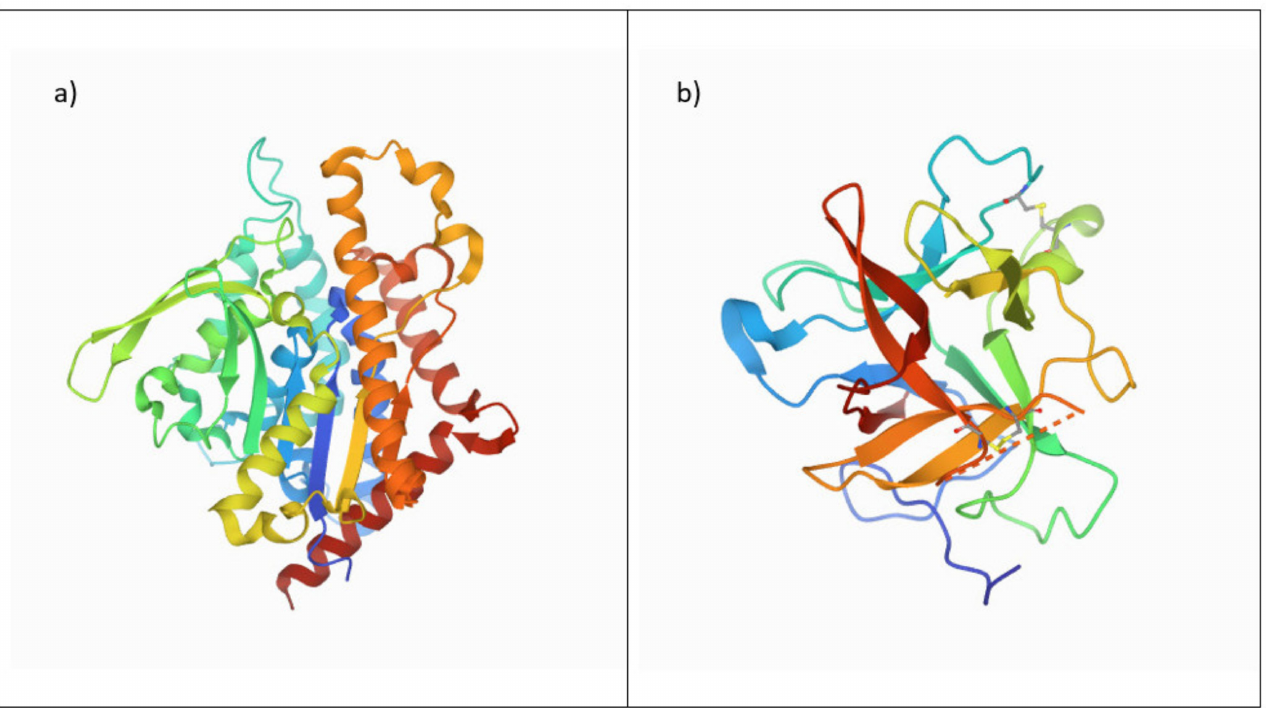
Figure 4. Images from the RCSB PDB (rcsb.org) of the tertiary structures of ( a ) native patatin, PDB ID 4PK9 [58] and ( b ) serine protease inhibitor, PBD ID 3TC2 [59], reprinted with permission from Ref. [59]. 2012, International Union of